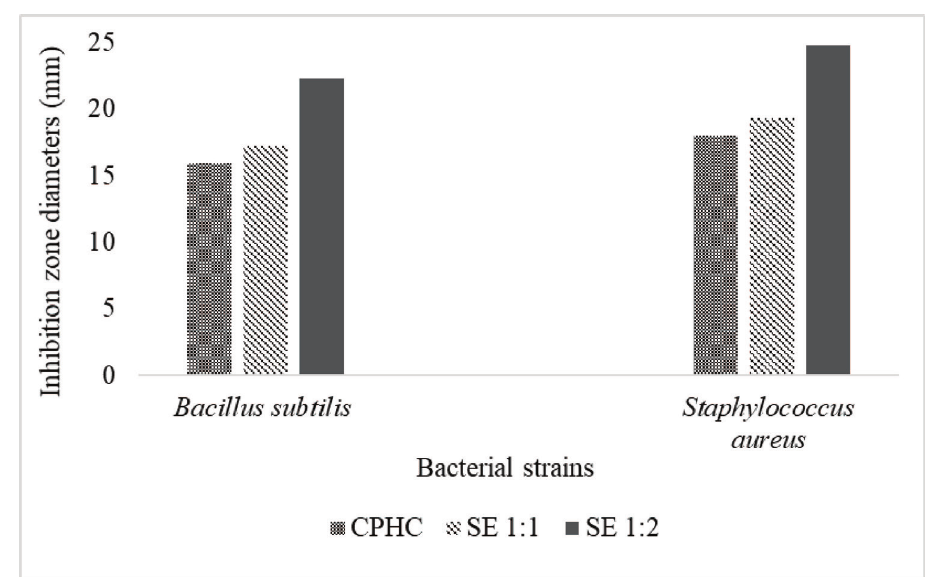
FIGURE 10 - Antibacterial activity of inclusion complexes prepared by solvent evaporation method compared with uncomplexed